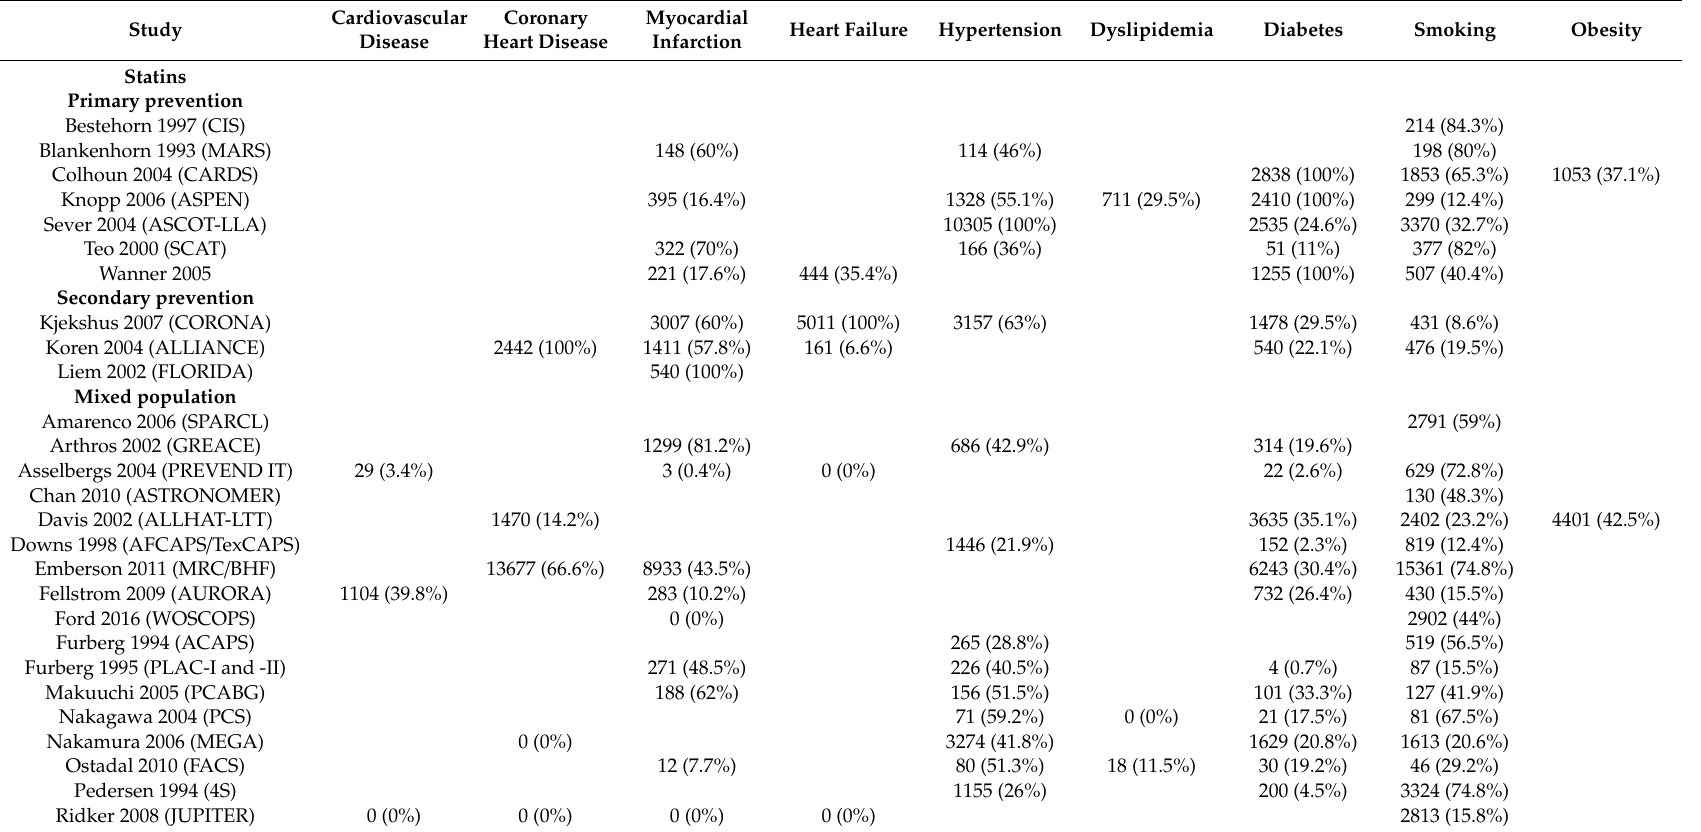
Table A2. History of cardiovascular events and risk factors of cardiovascular disease at